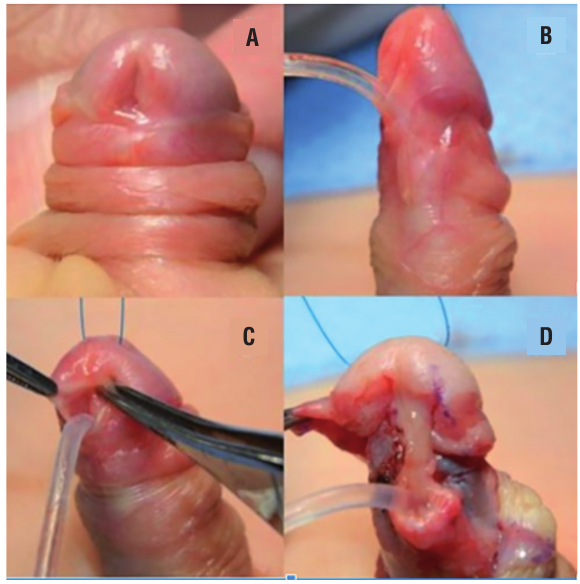
Figure 1 - GUD Technique – Partial Glandar Disassembly.